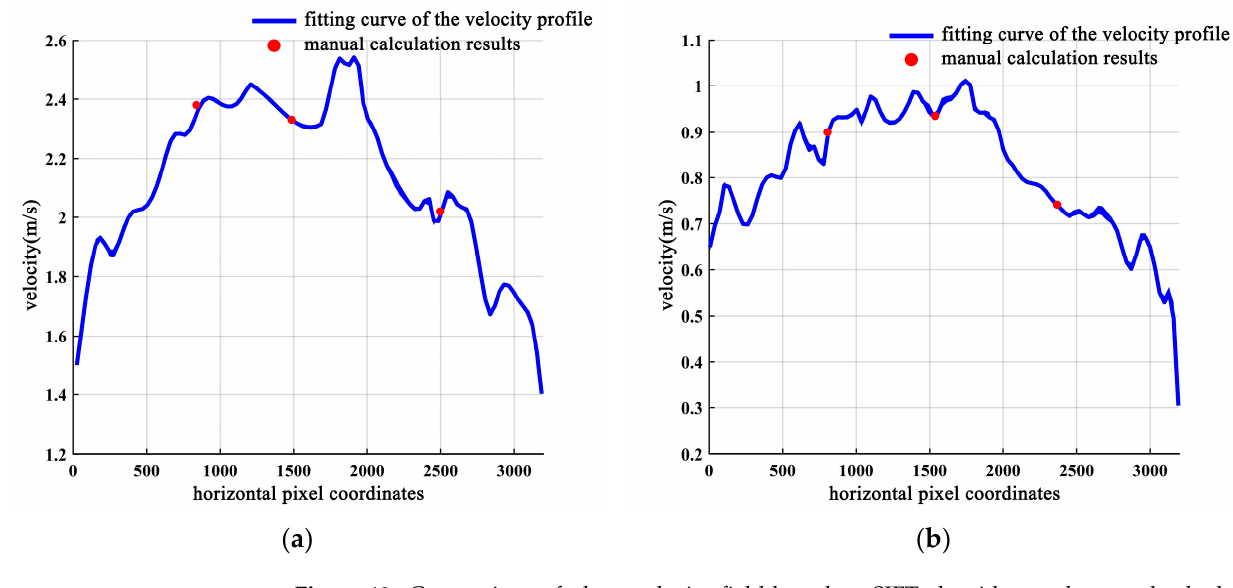
Figure 13. Comparison of plane velocity field based on SIFT algorithm and manual calculation: ( a )